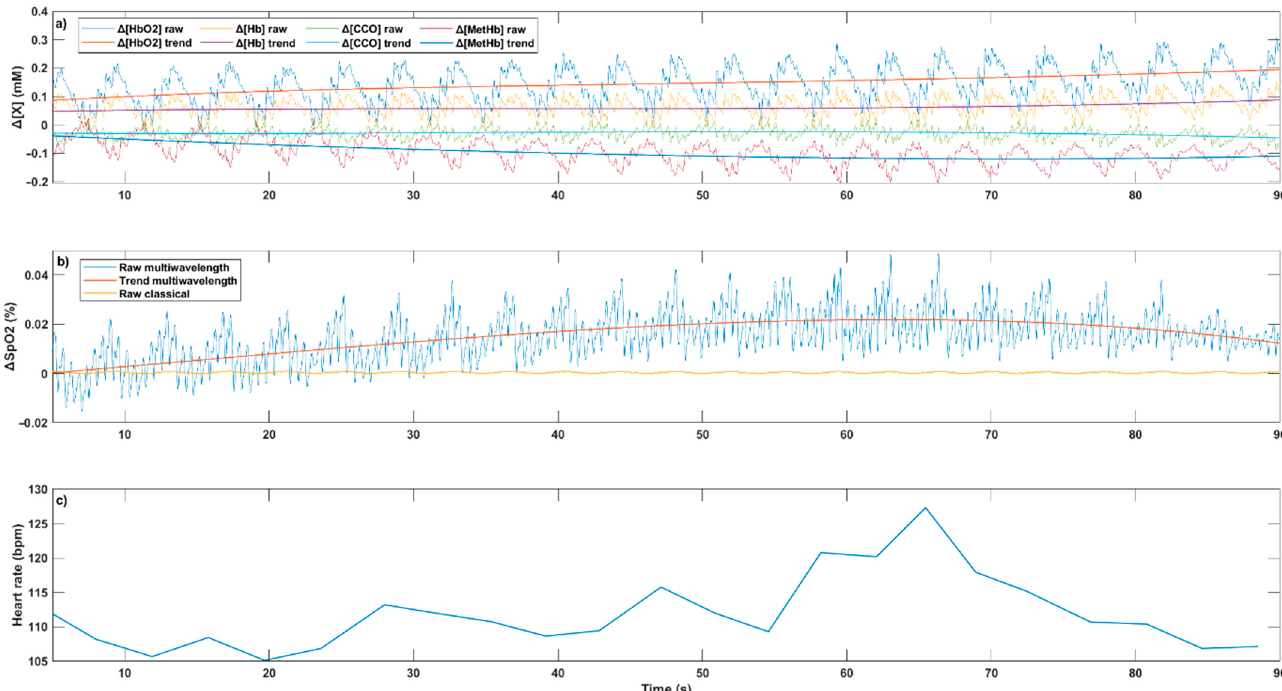
Figure 12. Variation in the chromophore’s concentration ( a ), oxygen level ( b ) and heart rate ( c ) at the spinal cord level with the electrostimulation (mM: mmol/L; %: percent; bpm: beats per minute).